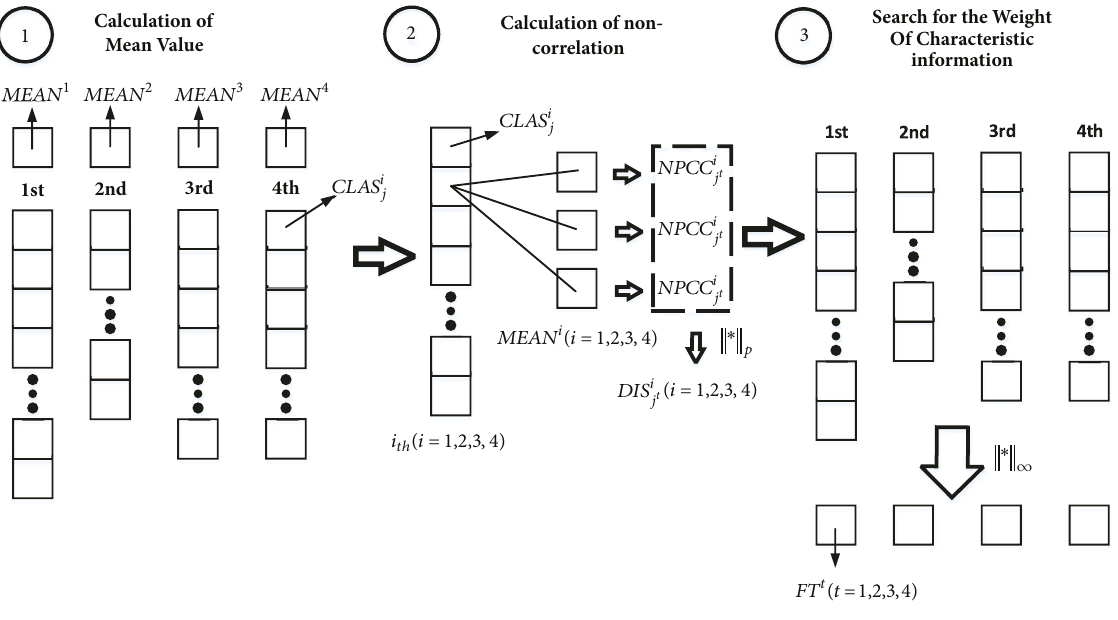
Figure 5: The specific process of Step 3.